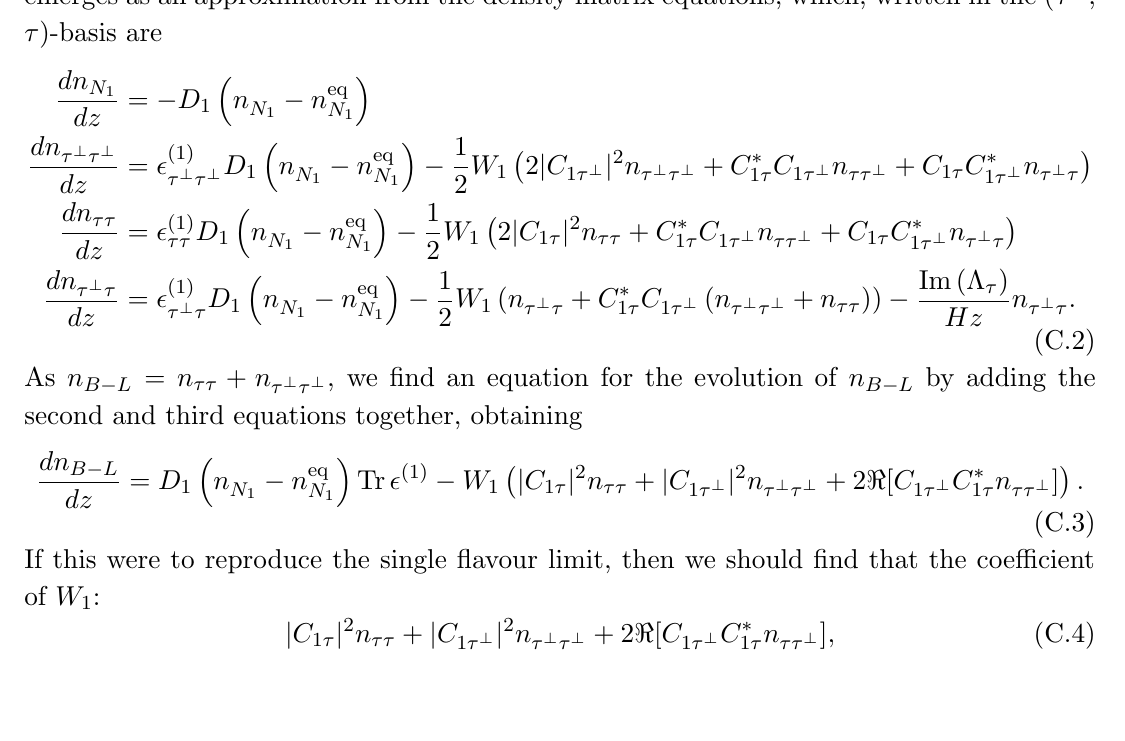
Figure 19 . The two-dimensional projections for leptogenesis with M 1 = 1 : 00 violation provided only by the phases of the PMNS matrix. The normal ordered case is coloured blue/green and inverted ordering orange/red and contours correspond to 68% and 95% con(cid:12)dence levels. This plot was created using SuperPlot